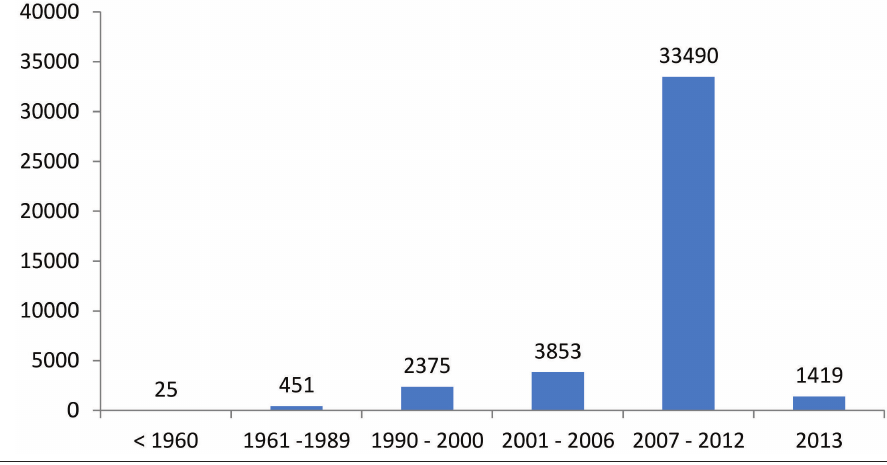
Figure 3. Temporal coverage of Herbarium FURB.